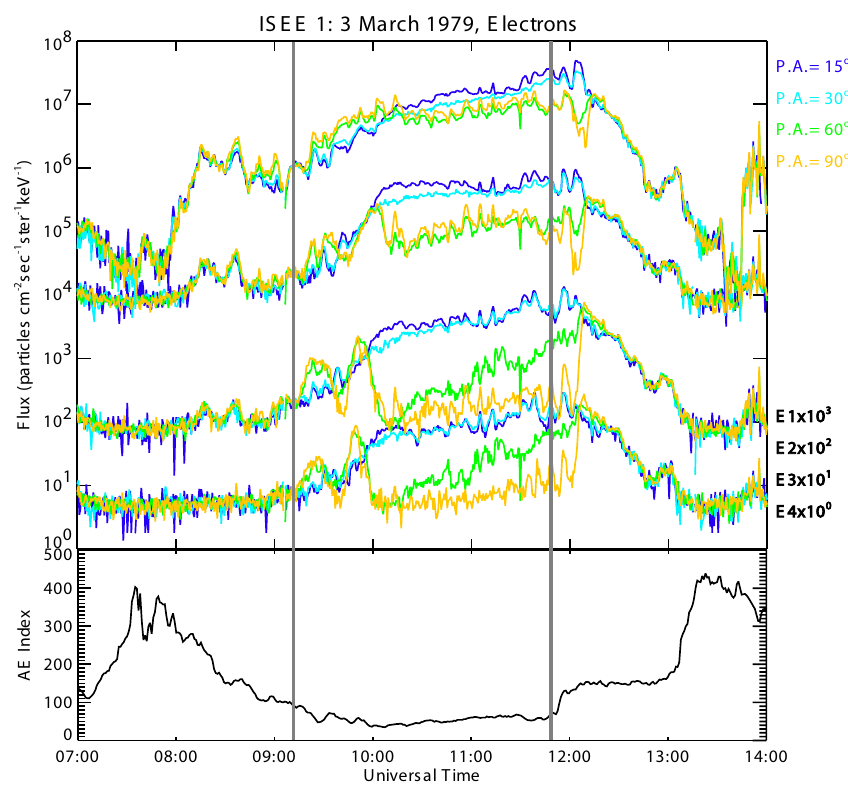
Fig. 4. Top panel displays the pitch angle flux distributions for electron channels E1 (22.5–39keV), E2 (39–75keV), E3 (75–120keV), E4 (120–189keV) observed by ISEE-1 for the time period of 07:00–14:00 UT. Pitch angles of 15 ◦ ± 5 ◦ , 30 ◦ ± 5 ◦ , 60 ◦ ± 5 ◦ , 90 ◦ ± 5 ◦ were sampled. Bottom panel is the AE index vs.